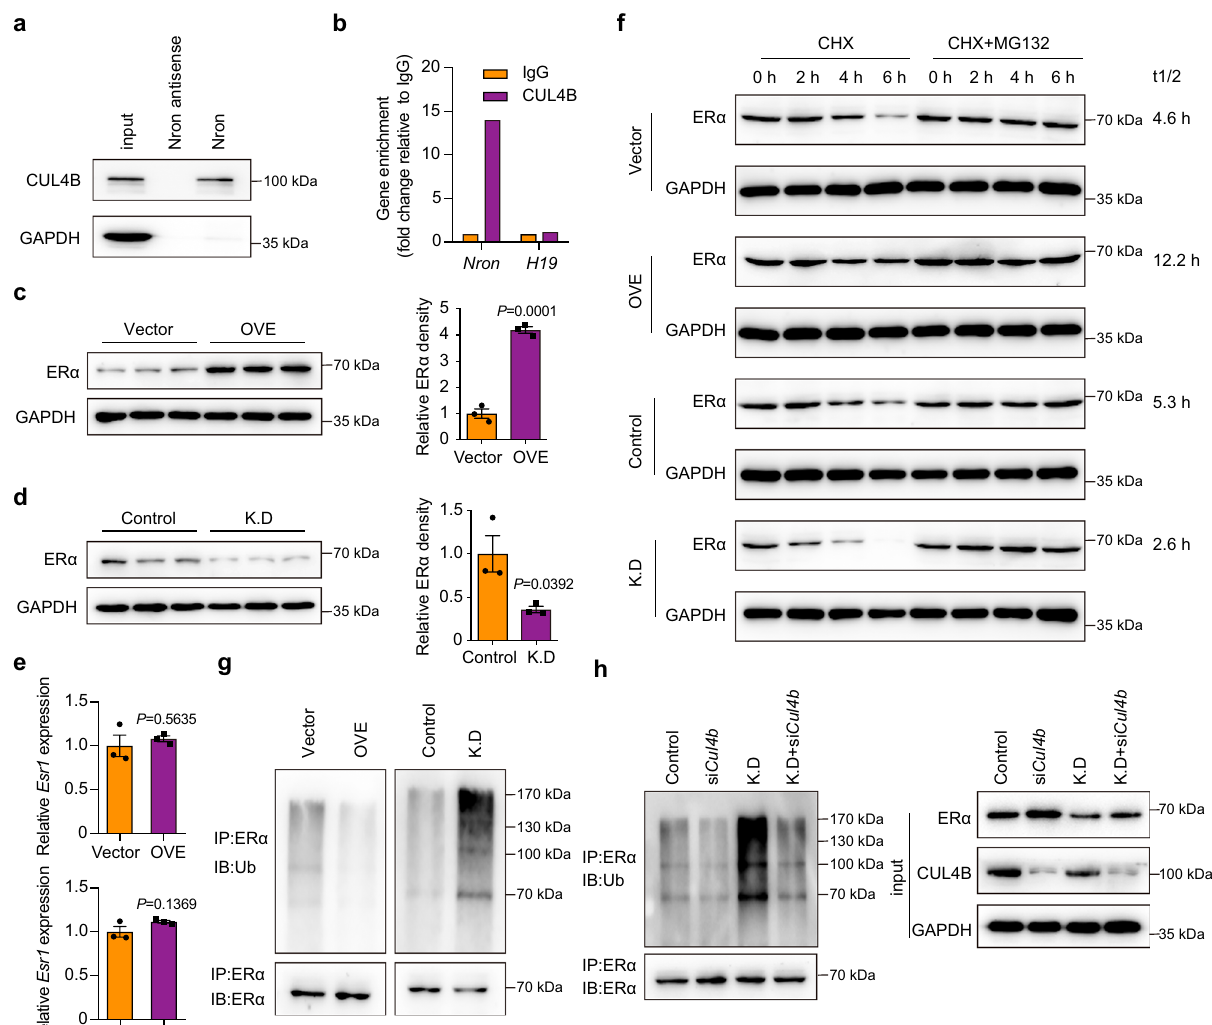
Fig. 4 Nron regulates ER α stability in osteoclasts. a RNA pull-down assay and b RNA immunoprecipitation assay in mouse osteoclasts showed speci fi c interaction between Nron and ubiquitin E3 ligase CUL4B. The experiment was repeated three times independently with similar results. c, d Expression of ER α in osteoclasts with Nron overexpression (OVE) or knockdown (K.D) analyzed by western blot (WB). The graph shows the relative ER α density (ER α / GAPDH levels, n = 3 biologically independent experiments). e Expression of Esr1 gene in osteoclasts with Nron overexpression or knockdown analyzed by Q-PCR, ( n = 3 biologically independent experiments). f The protein stability (t1/2) and the proteasome-mediated degradation of ER α assessed by measuring the decline of protein levels after CHX (10 μ g/ml) or CHX (10 μ g/ml) + MG132 (20 μ M) treatment in osteoclasts. The experiment was repeated three times independently with similar results. g The ubiquitination of ER α in Nron overexpression or knockdown osteoclasts was assessed by immunoprecipitation (IP) with anti-ER α antibody followed by ubiquitin WB analysis. The experiment was repeated three times independently with similar results. h Forty-eight hours after scramble or Cul4b siRNA transfection in Nron knockdown or control osteoclasts, the cells were treated with 20 μ M MG132 for 6 h, then the abundance of ubiquitinated ER α was assessed by IP with anti-ER α antibody followed by ubiquitin WB analysis. The experiment was repeated three times independently with similar results. Data are presented as the means ± s.e.m. Signi fi cant differences between two groups were determined by unpaired Student ’ s t -test (two-tailed). Source data are provided as a Source Data fi